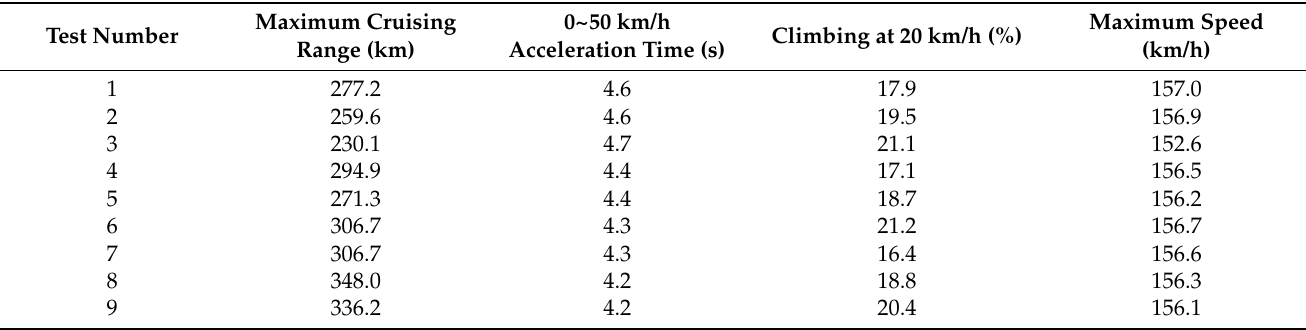
Table 9. Dynamic simulation test